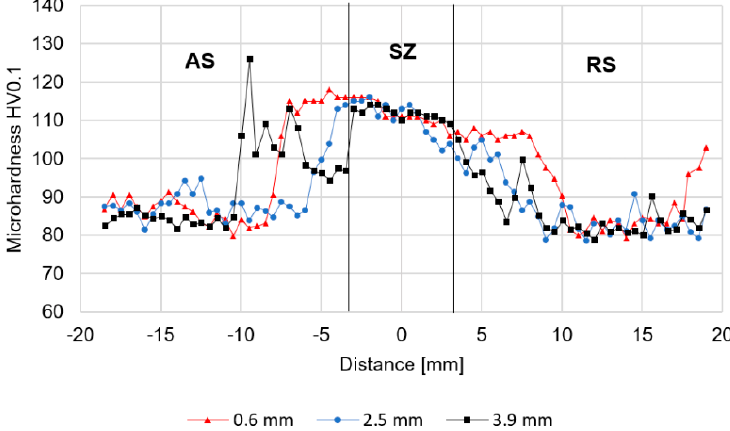
Figure 10. Distribution of microhardness in the A42 sample with respect to the distance from the top of the joint.